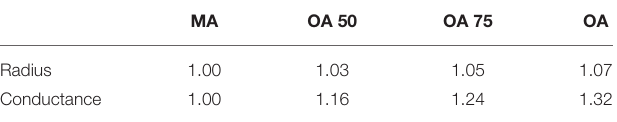
TABLE 2 | Physical characteristic ratios for interpolation between age